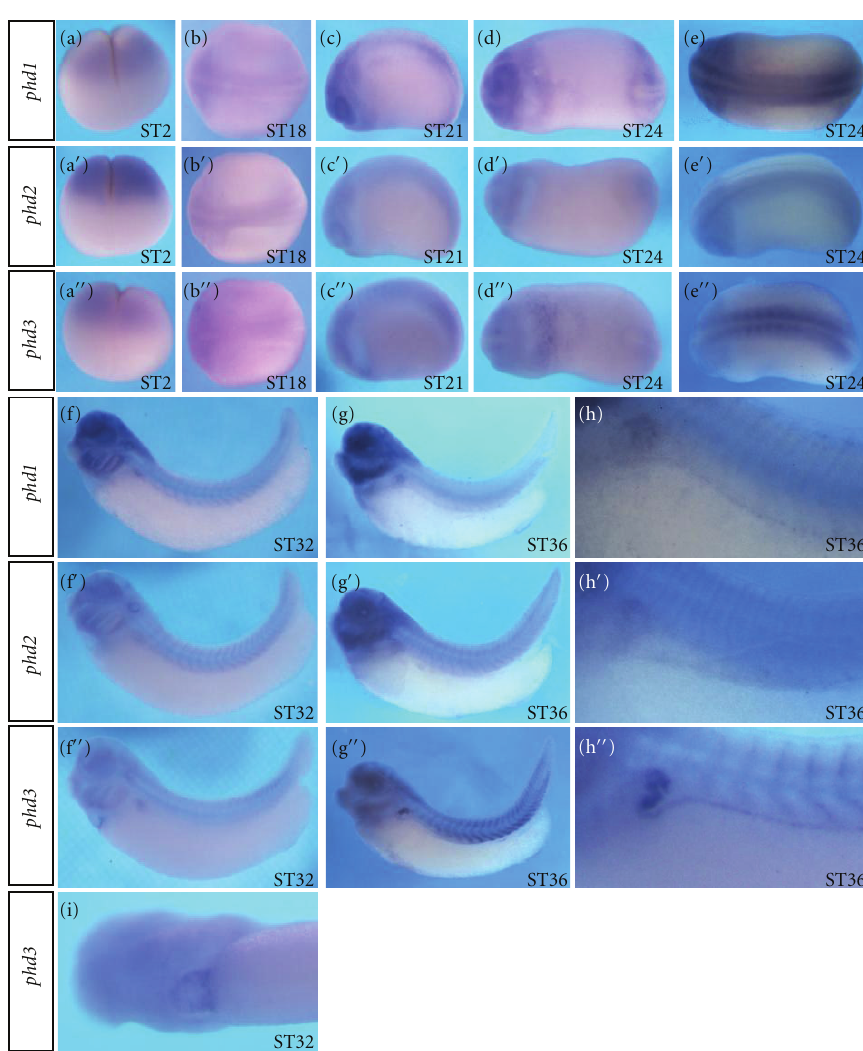
Figure 3: Spatial expression of phd1, 2, and 3 in Xenopus embryos revealed by whole-mount in situ hybridization. (a–a (cid:2)(cid:2) ) Lateral views with animal pole up. (b–b (cid:2)(cid:2) ) Dorsal views with head towards left. (c–c (cid:2)(cid:2) ) Lateral views with head towards left. (d–d (cid:2)(cid:2) ) Ventral views with head towards left. (e–e (cid:2)(cid:2) ) Dorsal views with head towards left. (f–g (cid:2)(cid:2) ) Lateral views with head towards left. (h–h (cid:2)(cid:2) ). Higher magnification views of (g), (g (cid:2) ), and (g (cid:2)(cid:2) ), respectively. (i) Ventral view of (f (cid:2)(cid:2) ) with head towards